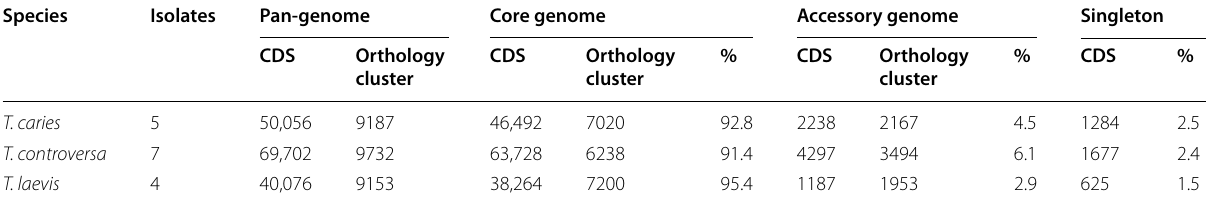
Table 4 Pan-genomes of T. caries , T. controversa , and T. laevis Species